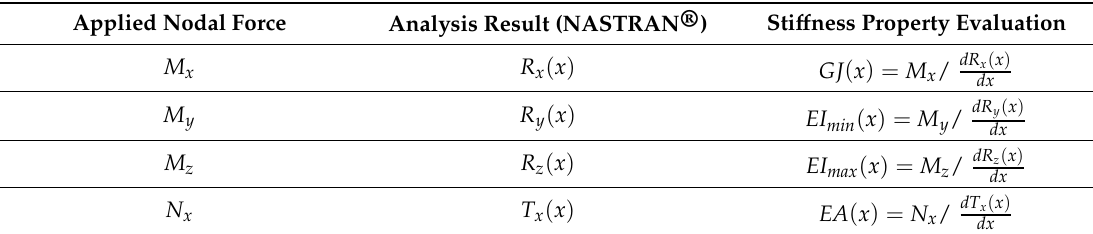
Table 5. Logical Flow for the sti ff ness properties